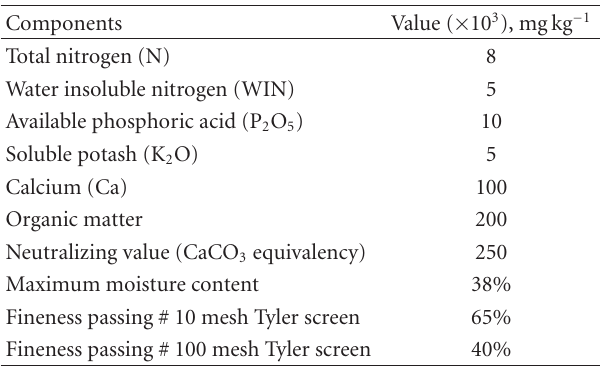
Table 1: Chemical composition of N-Viro biosolids on dry weight